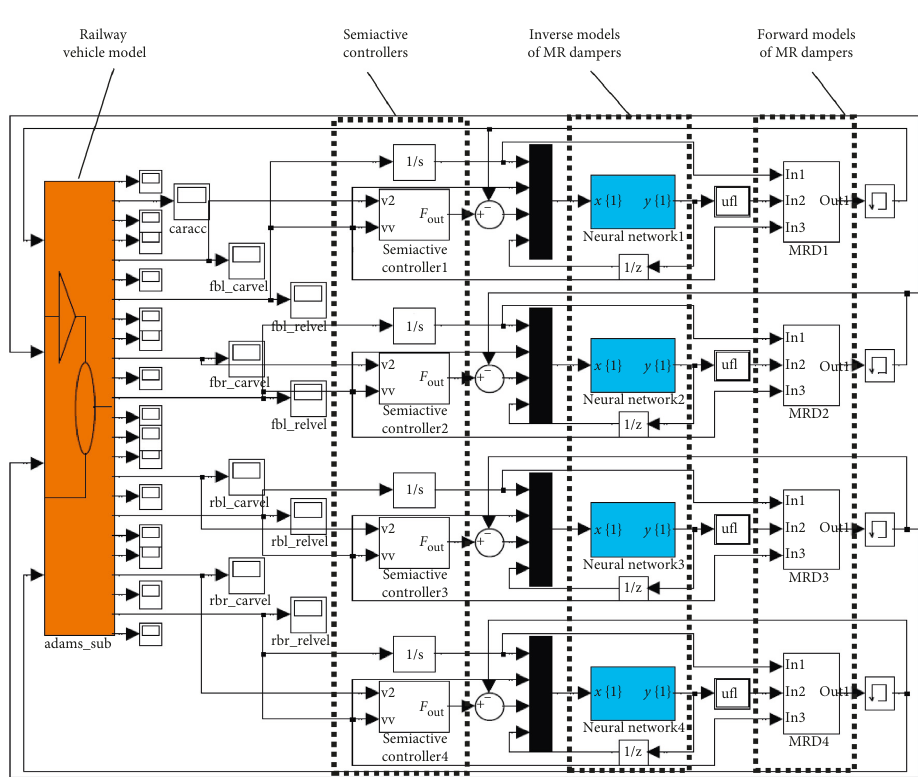
Figure 17: Semiactive suspension system model in SIMULINK.